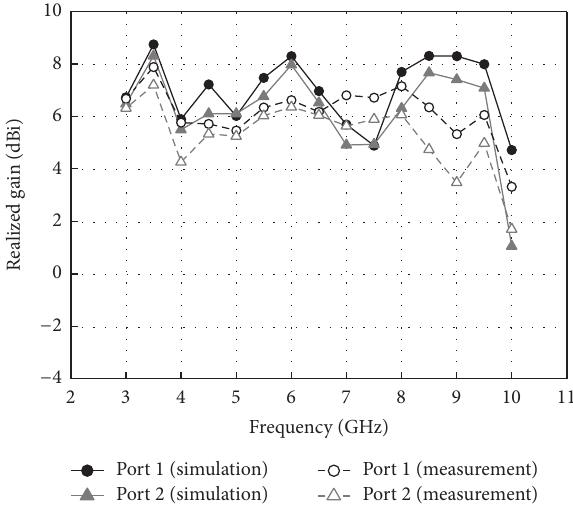
Figure 9: Simulated and measured realized gain versus frequency.